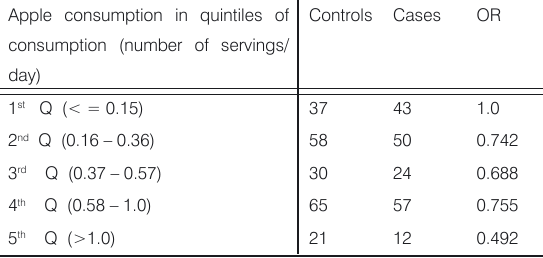
Table 4. Crude estimates of colorectal cancer risk related to level of daily consumption of apples (in